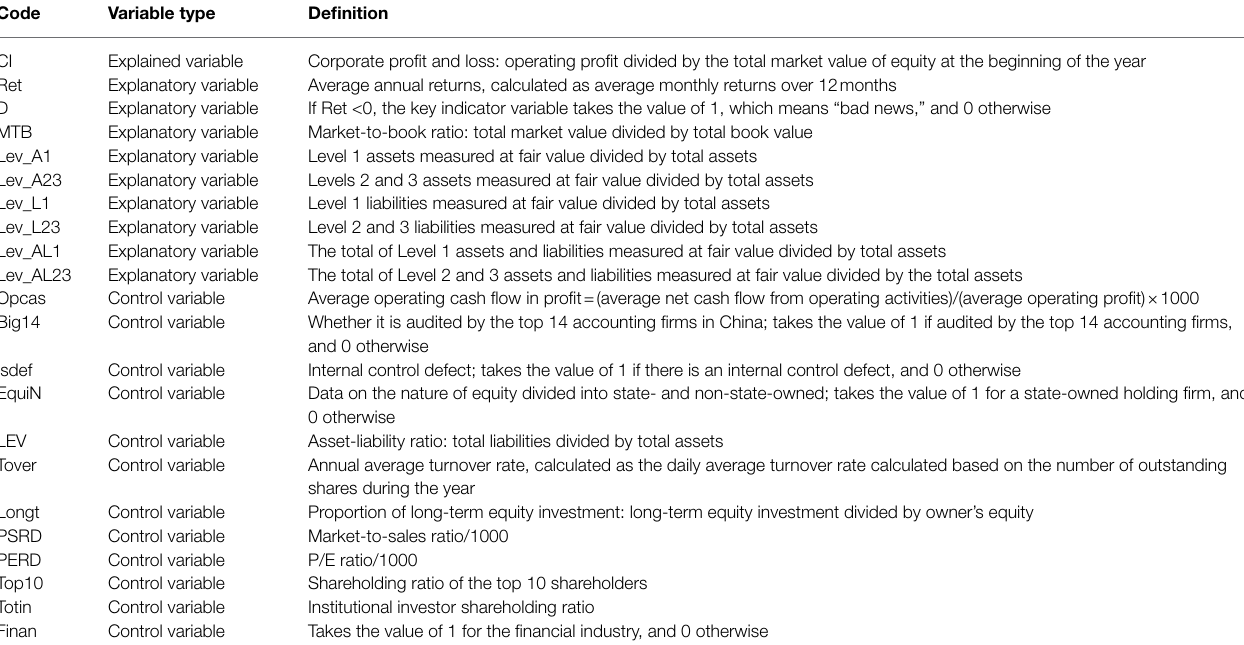
TABLE 1 | Variable definitions. Code Variable type Definition CI Explained